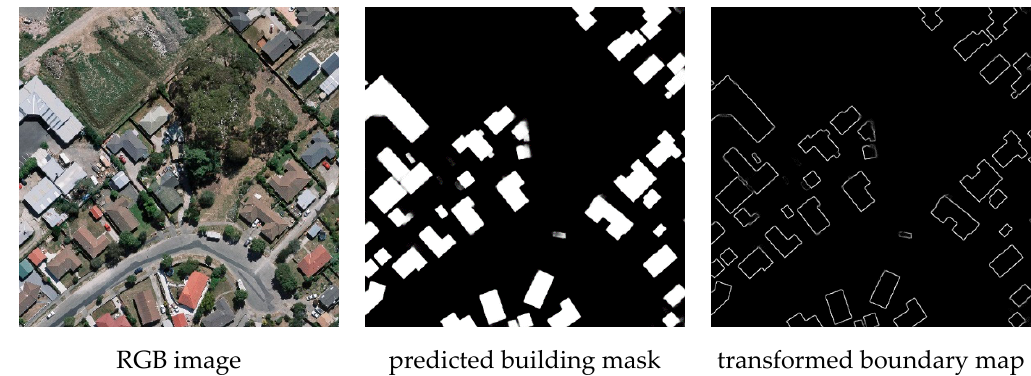
Figure 5. Examples of predicted building masks and corresponding transformed boundary maps via the M → B transforming layer (i.e., f m → b ( x ) ).